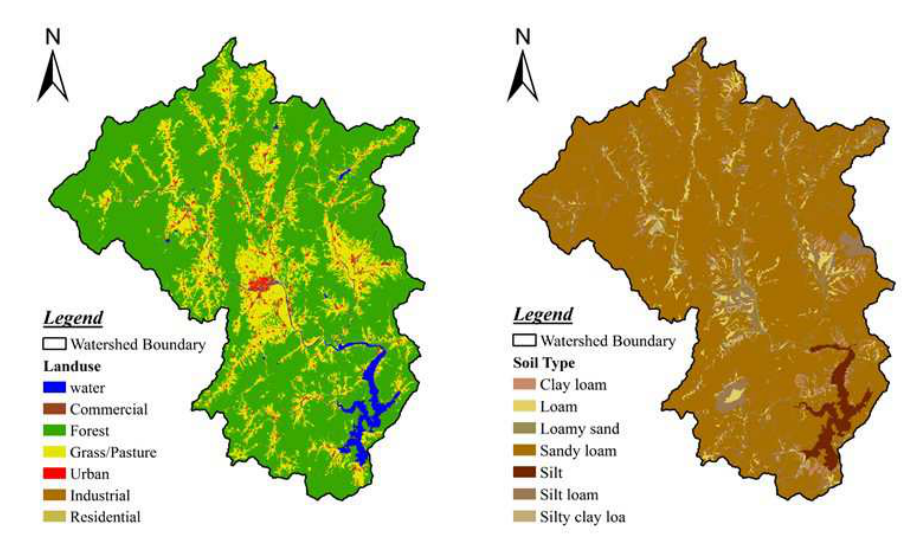
Figure 4. Land use and soil map.